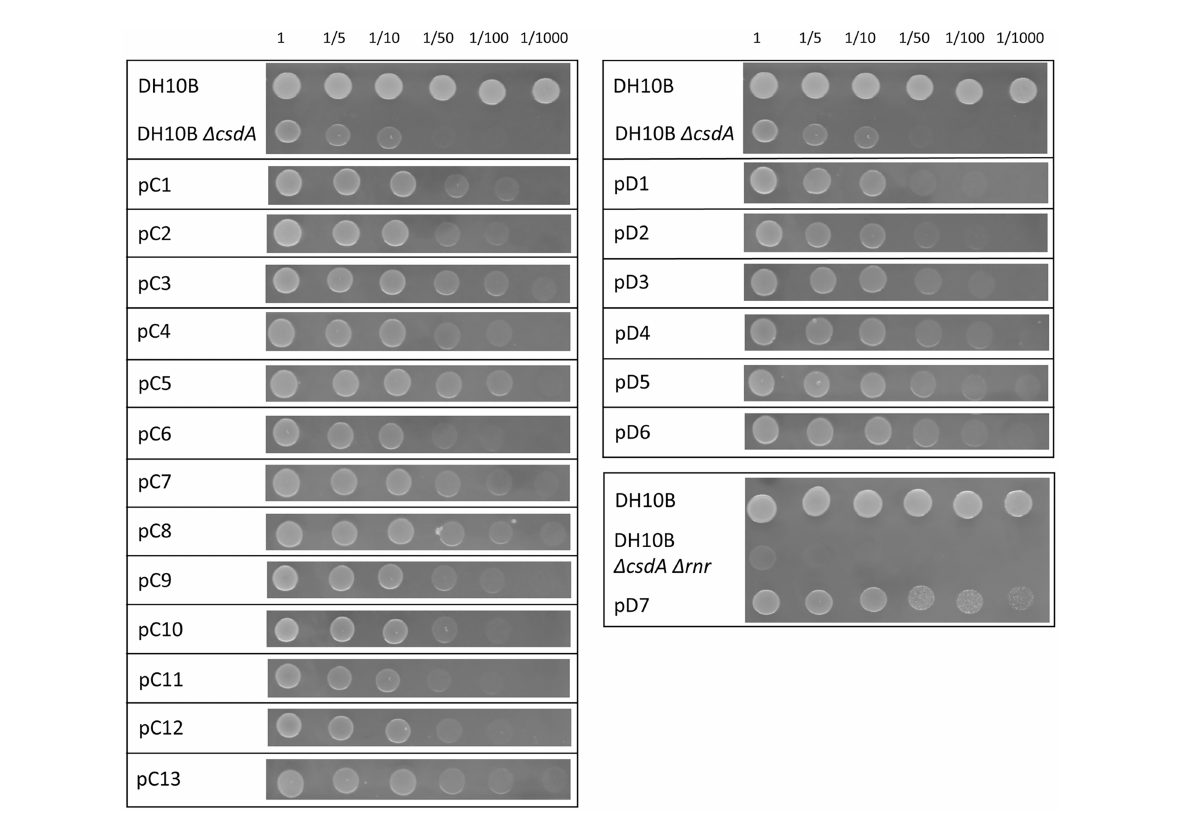
FIGURE 1 Drop assay of the 20 cold-resistant clones isolated from Antarctic metagenomic libraries: library C constructed from Colobanthus quitensis rhizosphere samples and library D from Deschampsia antarctica rhizosphere samples. The DH10B strain carrying an empty pBluescript vector was used as a positive control and both cold-sensitive strains (DH10B Δ csdA and DH10B Δ csdA Δ rnr ) also carrying empty pBluescript vectors were used as negative controls. The OD 600 nm of overnight cultures was adjusted to values of 1.0 and serial dilutions were performed. 10 μl drops were inoculated on LB-Ap 50 plates and grown at 15 ° C for 10 days. Each experiment was repeated at least three times using independent